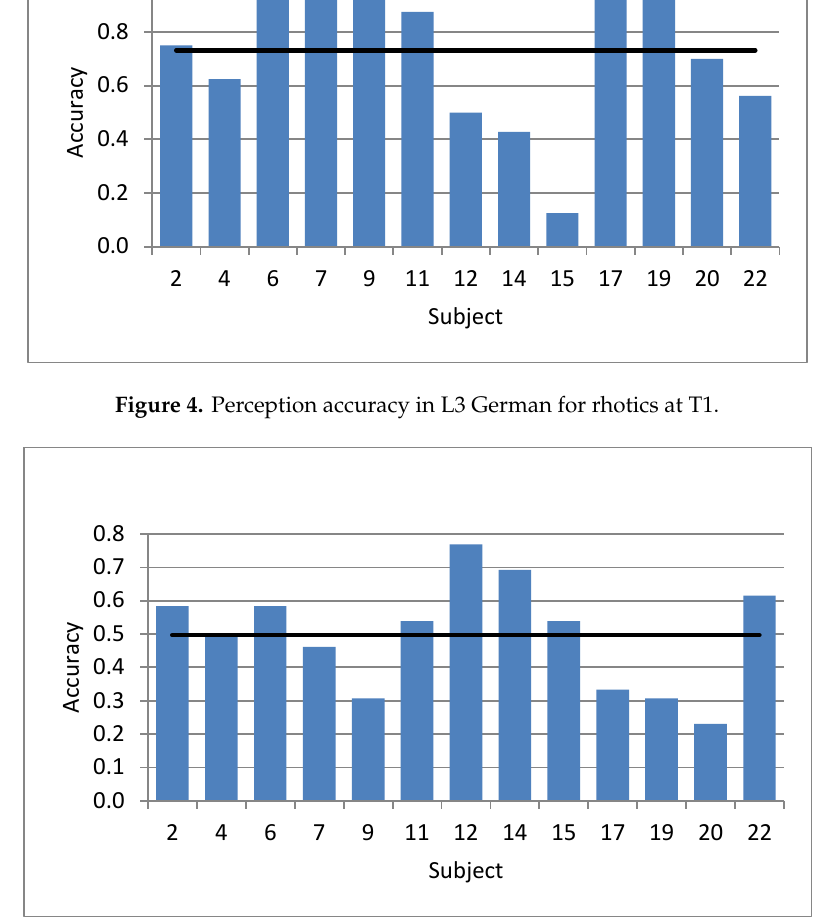
Figure 5. Perception accuracy in L2 English for obstruent devoicing at T2.